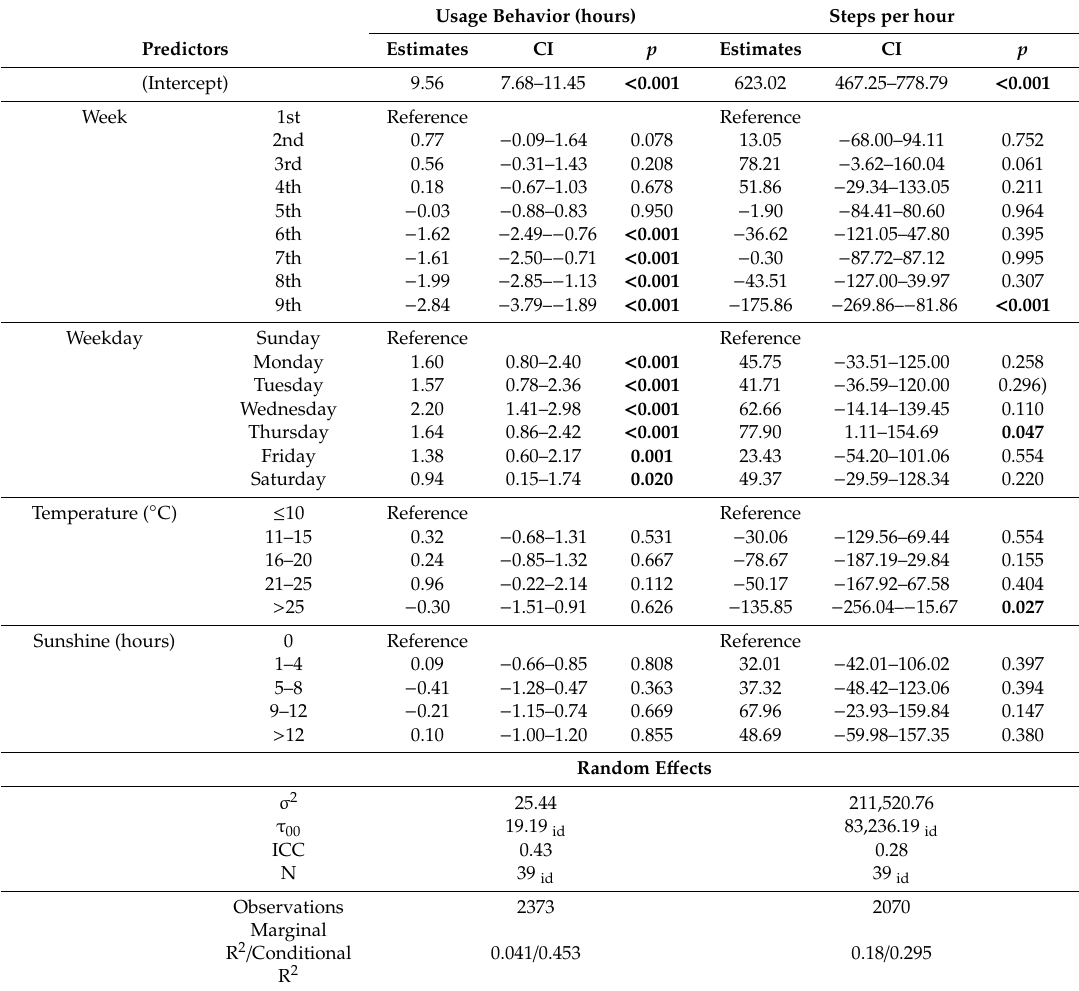
Table 2. Determinants of usage behavior and steps per hour. Mixed linear models, p -values for p < 0.05 are shown in bold. (CI = confidence interval; id =